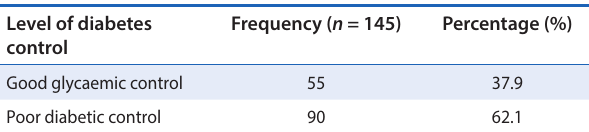
Table 2: Frequency distribution of the level of diabetes control among the study population Level of diabetes control